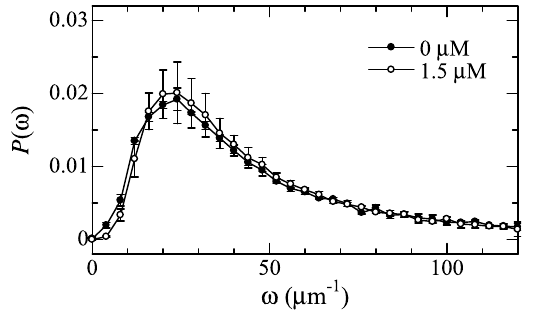
Figure 4. Density of states of colloidal glasses at polymer concentrations of 0.0 and 1.5 μ